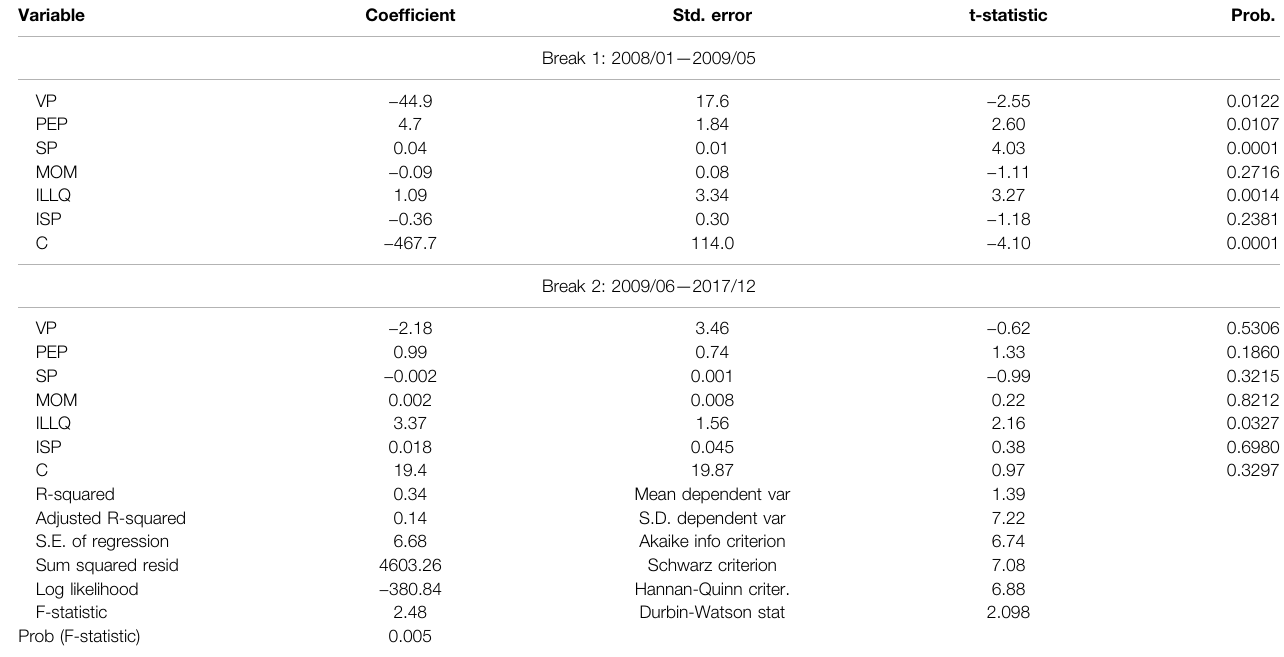
TABLE 6 | Robustness test. Variable Coef fi